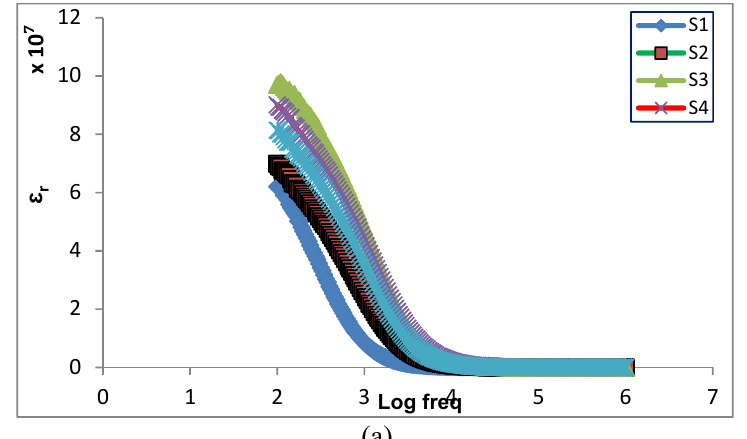
Fig.3: Dielectric constant vs. Log frequency at RT with different salts concentration for electrolytes, (a)